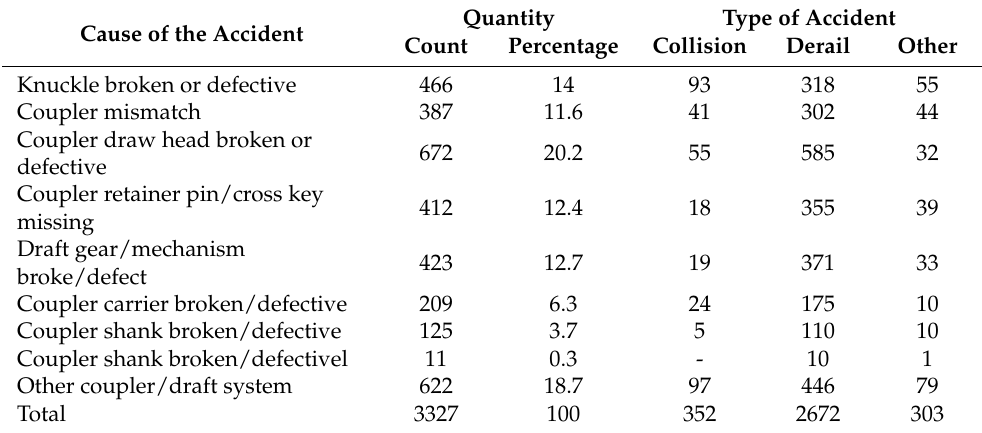
Table 1. Accidents or events related to train integrity caused by train coupler and traction devices.